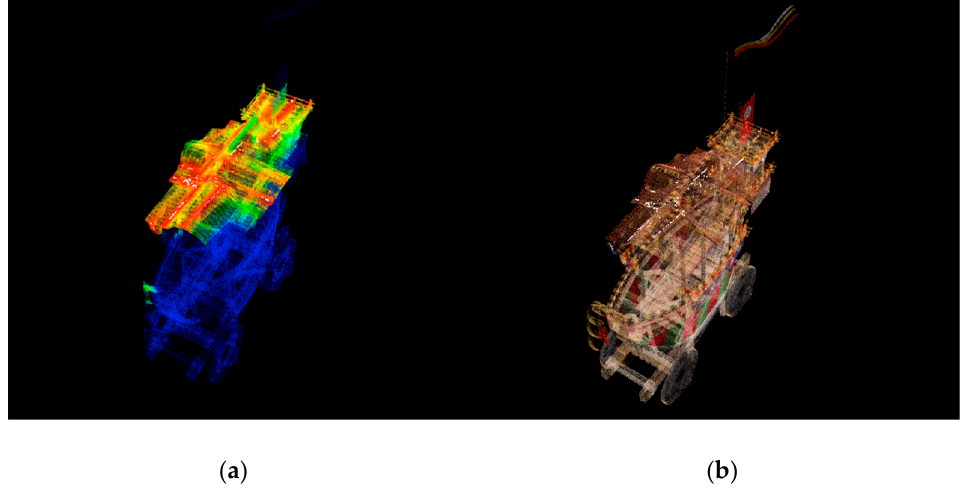
Figure 13. Visualization results of the Ofune-hoko float: ( a ) Transparent collision visualization of the Ofune-hoko float without showing the point cloud of the street, and ( b ) only the collision areas of the float are highlighted in white.